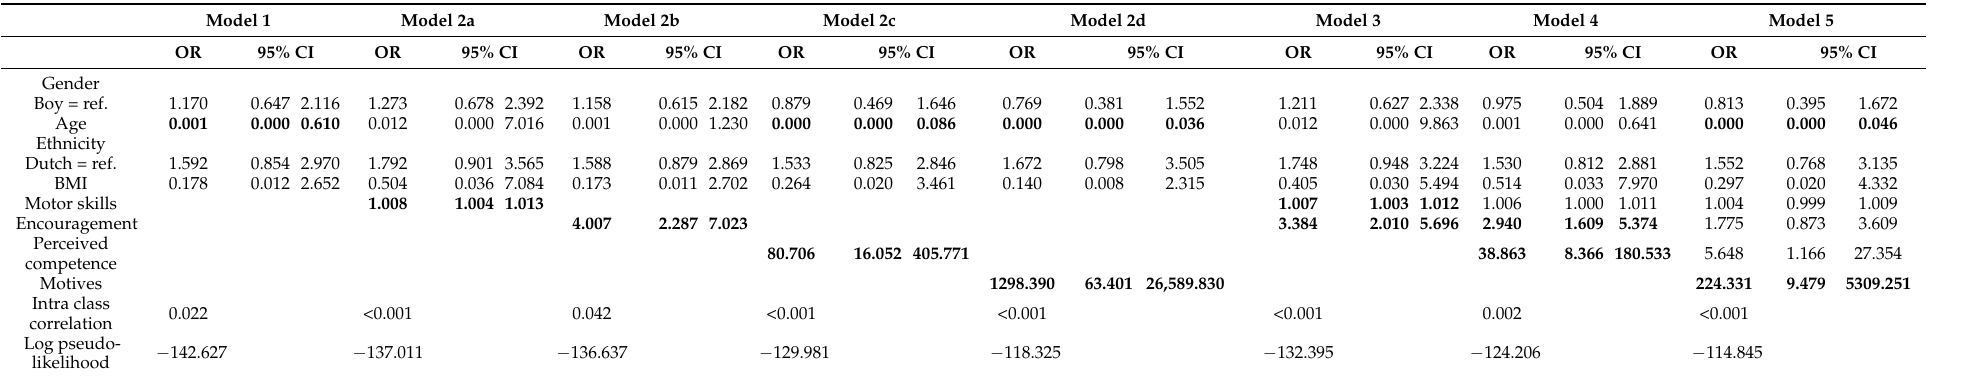
Table 2. Multilevel multivariate logistic regression analyses on sport